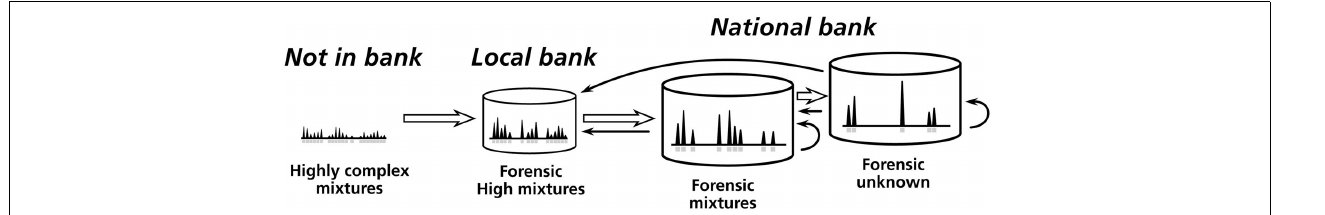
FIGURE 2 | The processes of mixture databanking and comparison at LSJML. The complexity of profiles decreases from left to right, i.e., from highly complex mixtures that cannot be deposited as is in databank to single-source profiles stored under the “forensic unknown” index. “Forensic high mixture” and “Forensic mixture” are two intermediate indexes, respectively stored at the local (LSJML) and national (NDDB)